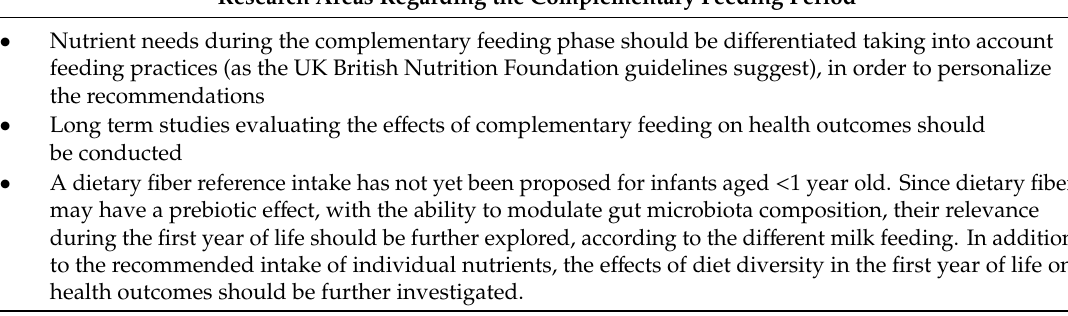
Table 3. Complementary feeding: gaps to be filled.